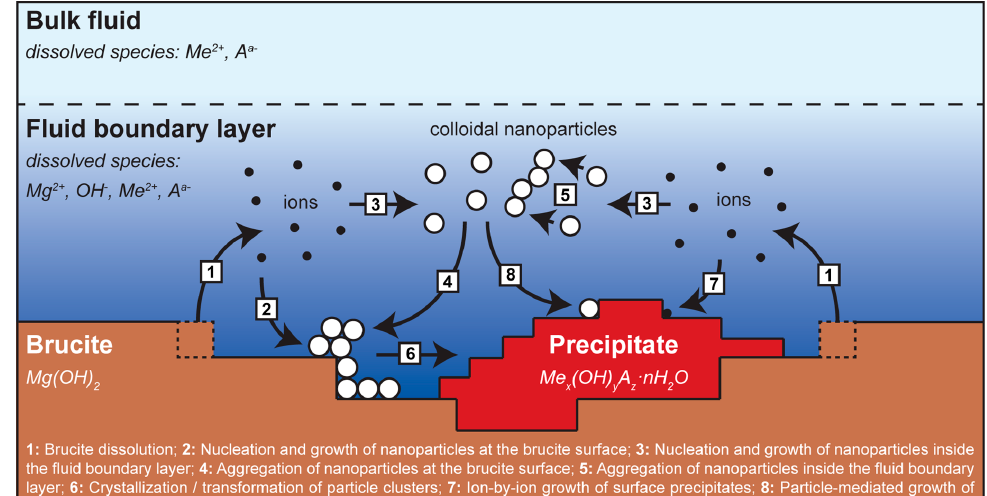
Figure 7. Schematic illustration of coupled dissolution–precipitation pathways at the brucite–water interface (see main text for more detailed explanations).